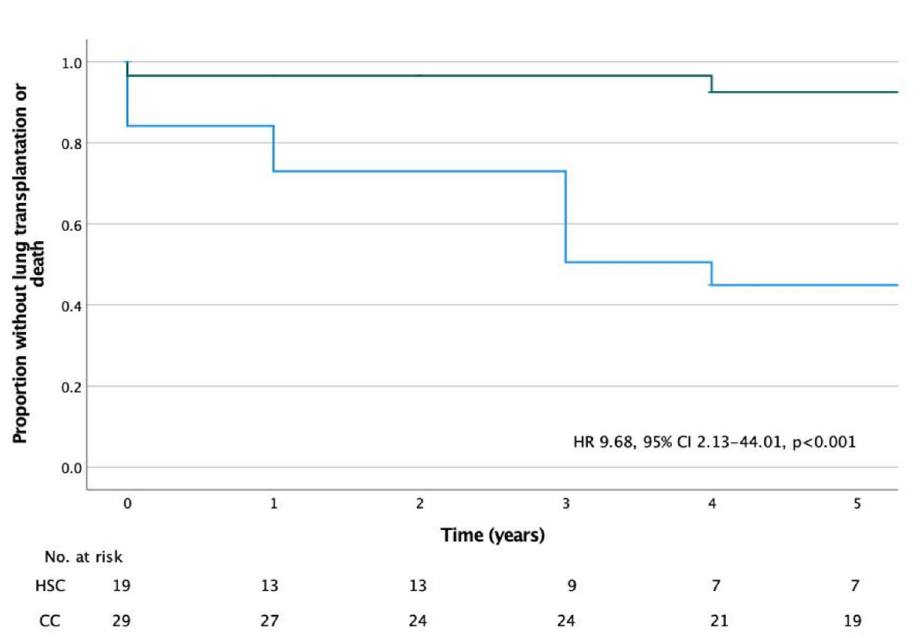
Figure 2. Kaplan Meier survival curve free from death/transplantation from the time of sirolimus initiation. HSC (blue) and CC